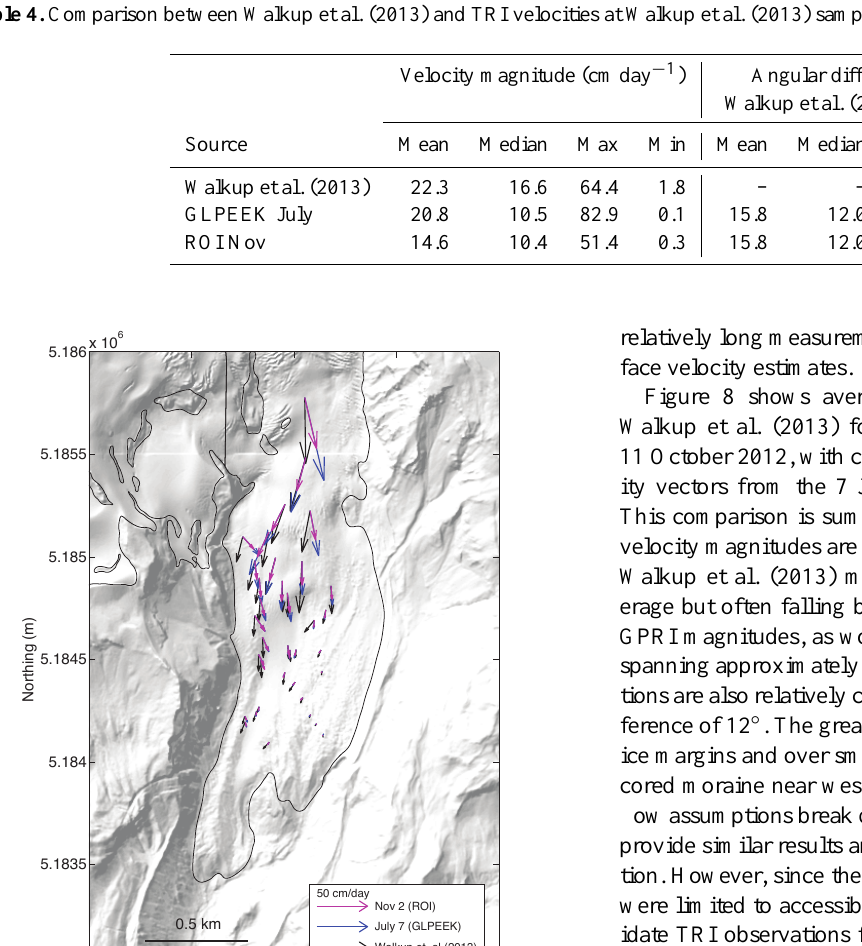
Table 4. Comparison between Walkup et al. (2013) and TRI velocities at Walkup et al. (2013) sample locations (Fig. 8).